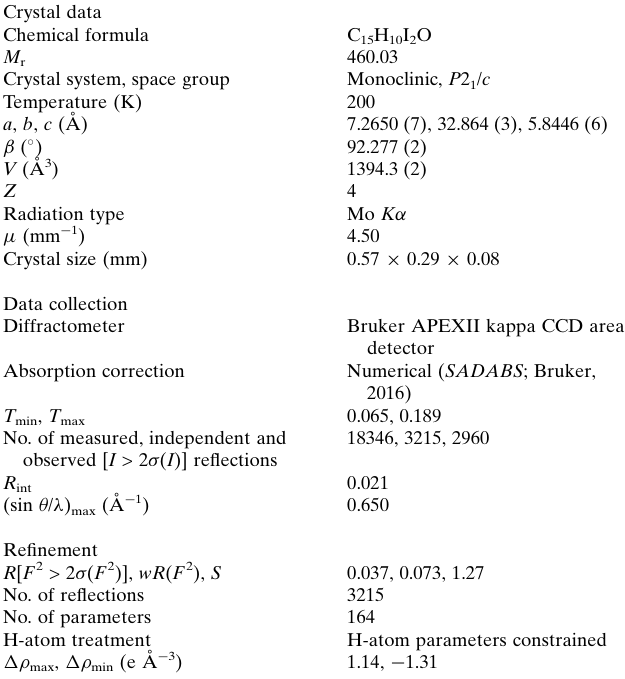
Table 2 Experimental details. Crystal data Chemical